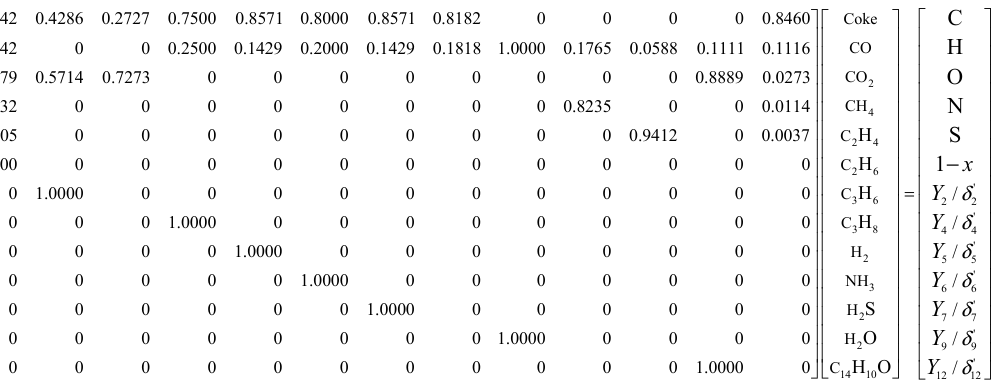
Figure 3. Matrix for calculating the yields of oil shale pyrolysis products.